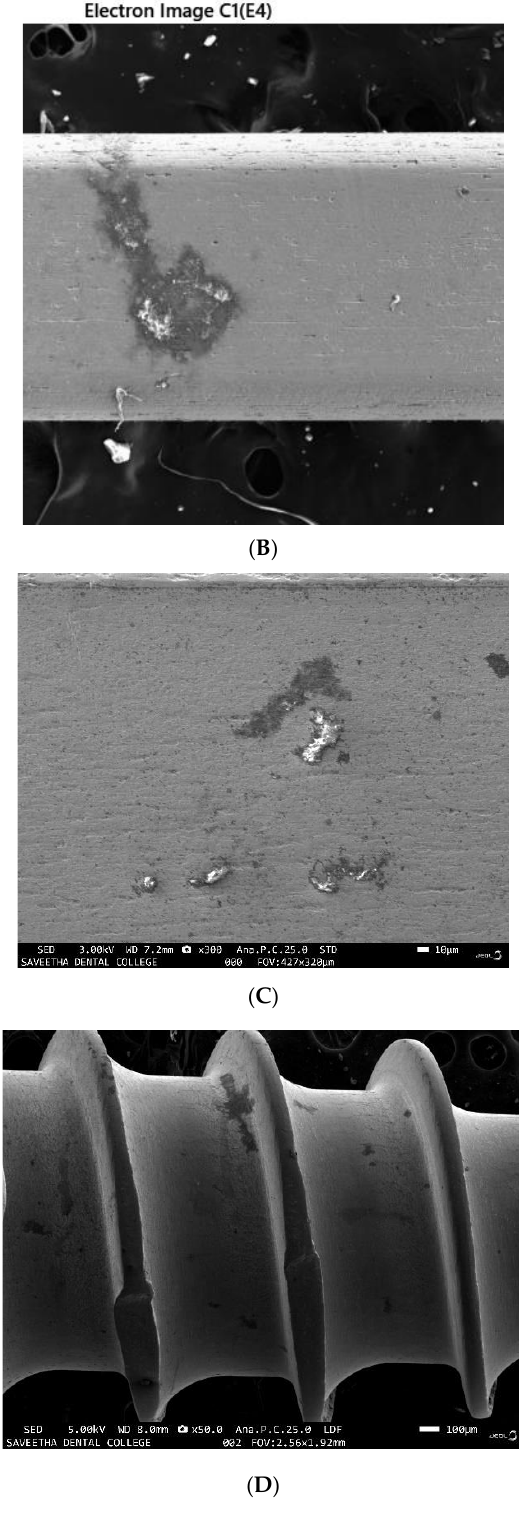
Figure 3. Corrosion patches observed on various archwires ( A ) 0.016 NiTi wire ( B ) SS wire ( C ) TMA wire ( D ) Mini implant Titanium screw. wire ( D ) Mini implant Titanium